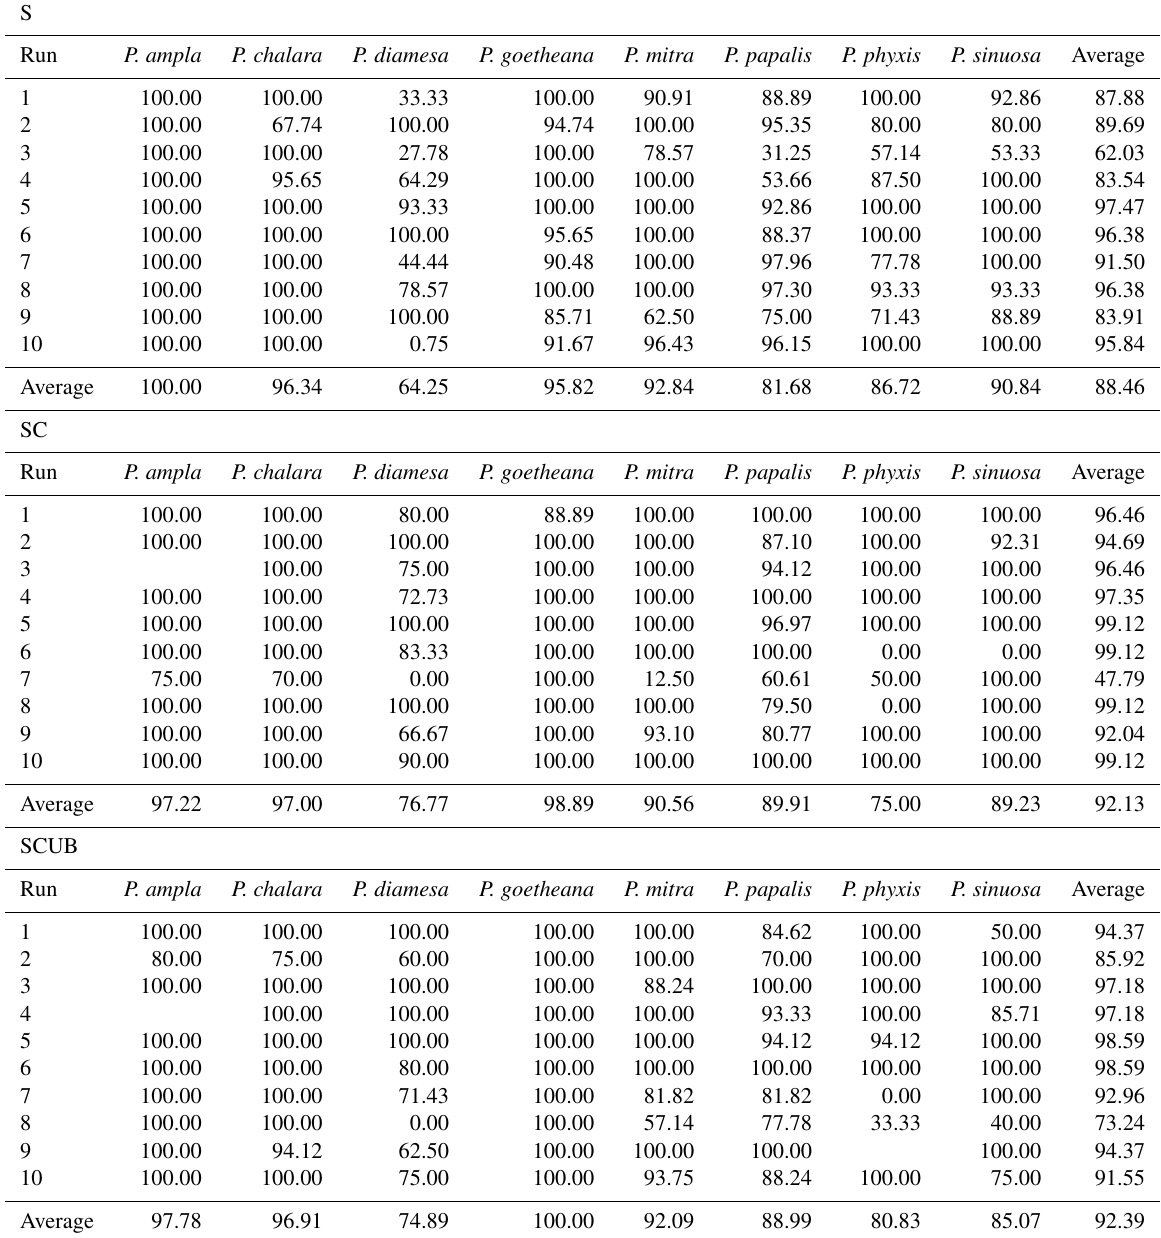
Table 3. Validation accuracies for all the studied species over 10 runs for each one of the three datasets, and their average values based on the results of the species accuracies from Supplement